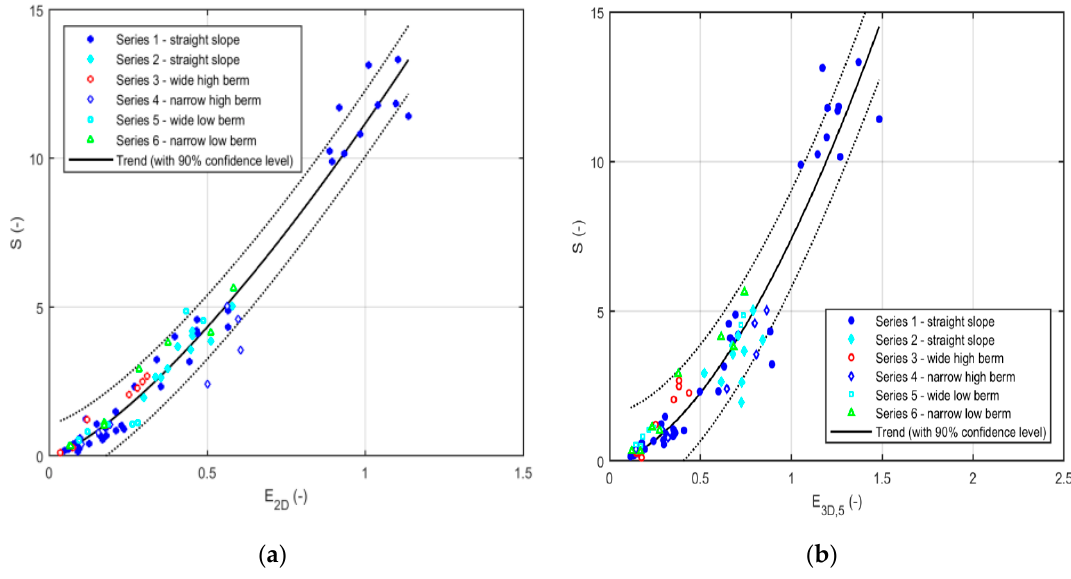
Figure 6. ( a ) Measured damage values, S (based on the eroded area) versus E 2D (based on the erosion depth); ( b ) damage values, S (based on the eroded area) versus E 3D,5 (characterisation width 27 stone diameters).